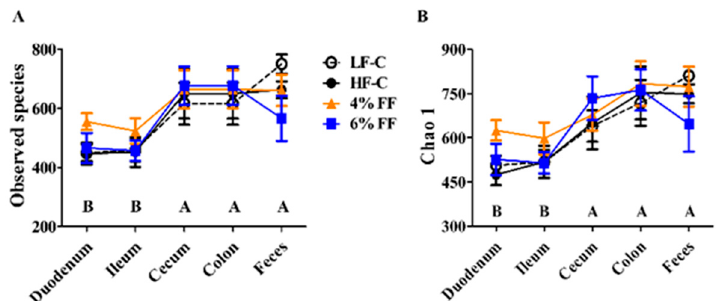
Figure 2. Changes in microbial α diversity in different intestinal segments: ( A ) the number of ob ‐ served OTUs, and ( B ) the bias ‐ corrected Chao richness estimator (Chao 1). Data are represented as mean ± S.E.M., n = 5–7. Significance is considered at p < 0.05. AB means in the same bar without a common letter differ at p < 0.01.